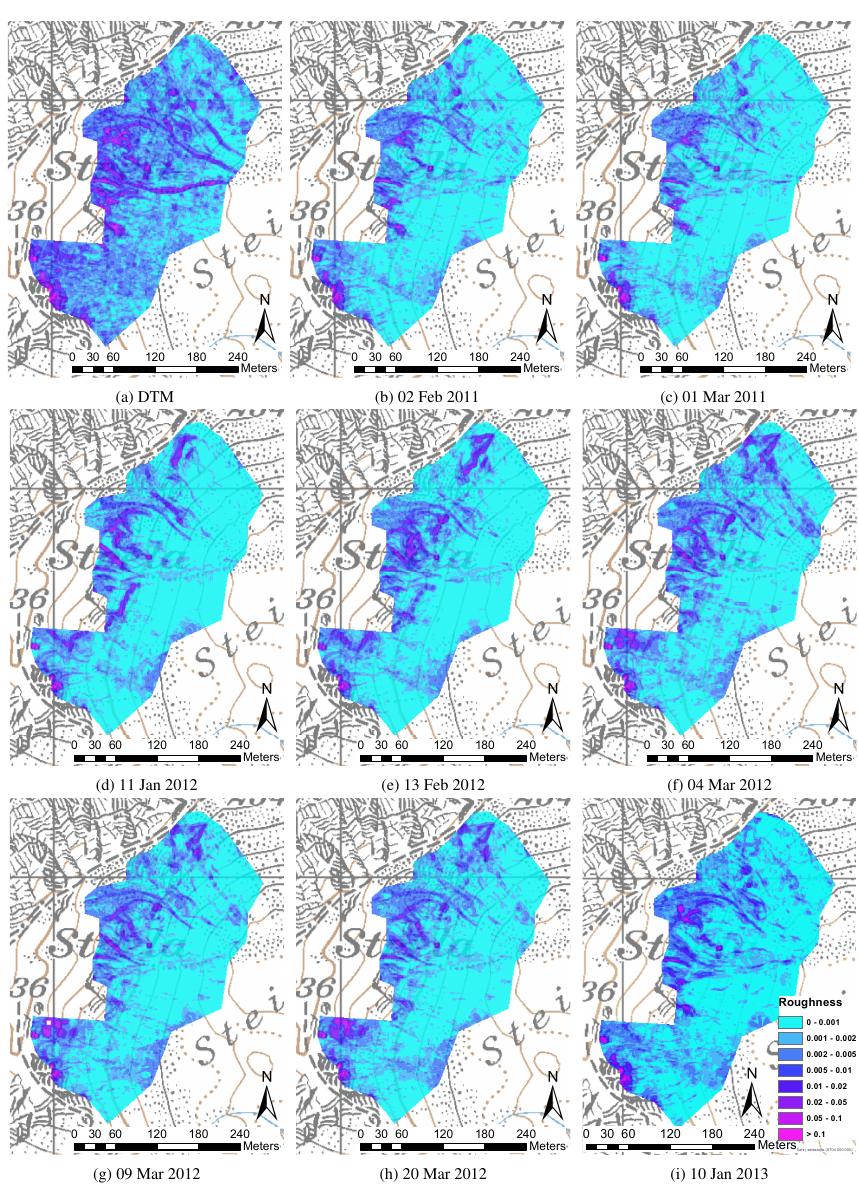
Fig. A1. Surface roughness of summer terrain and winter terrain at a scale of 5m in the basin ST. Pixmaps © 2013 swisstopo (5704 000 000).